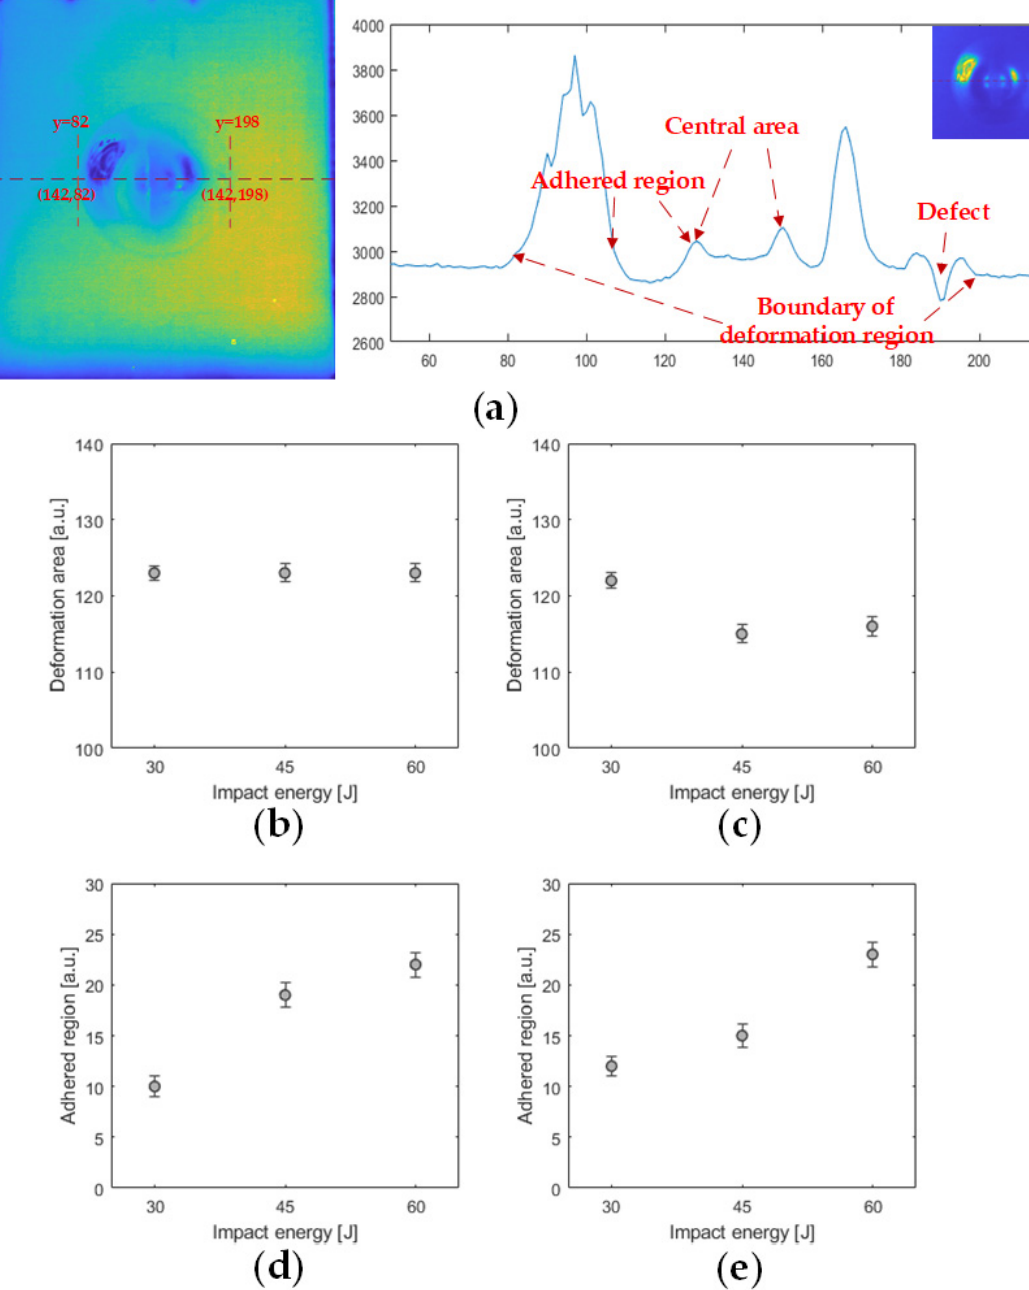
Figure 10. Quantitative analysis of the PT experiments: ( a ) analysis on the temperature curve of the Al_G_60J sample; ( b ) deformation area of Al_B samples; ( c ) deformation area of Al_G samples; ( d ) concave area of Al_B samples; ( e ) concave area of Al_G samples.